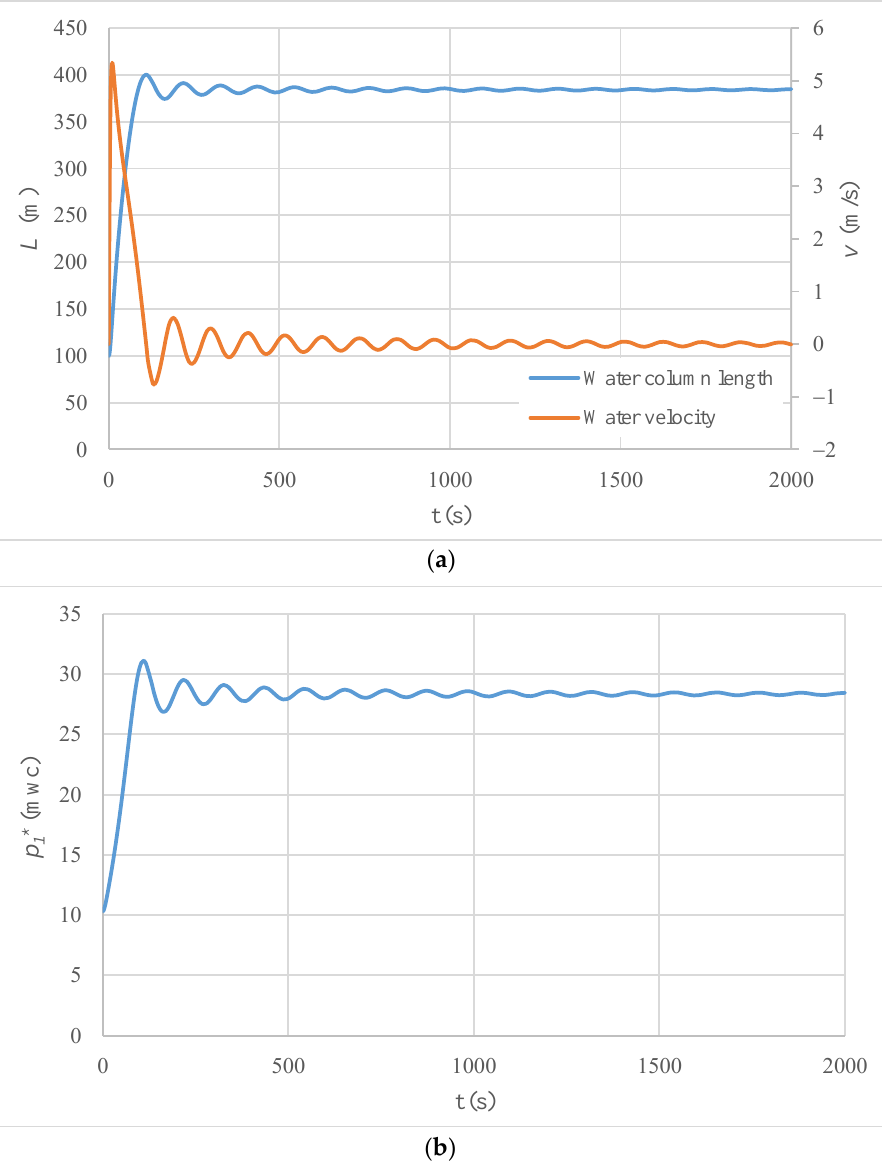
Figure 3. Evolution of hydraulic and thermodynamic variables: ( a ) water velocity and water column length; and ( b ) air pocket pressure.